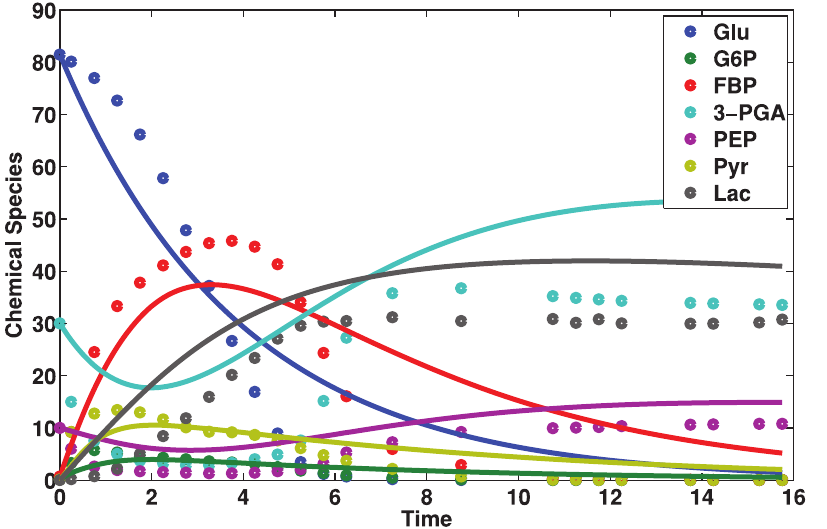
Figure 5. Input and Output time course data for the glycolytic pathway. The pathway describes interactions between seven chemical species. Open circles represent the input time course data. Solid lines represent the output time course data. We produced the output using the Empirical information criterion. The predicted time course data does not fit perfectly the experimental data. However there is a good qualitative agreement with the experimental data behavior. In addition, MIKANA is capable of reconstructing an interaction mechanism in close agreement with the Lactococcus lactis glycolytic pathway.